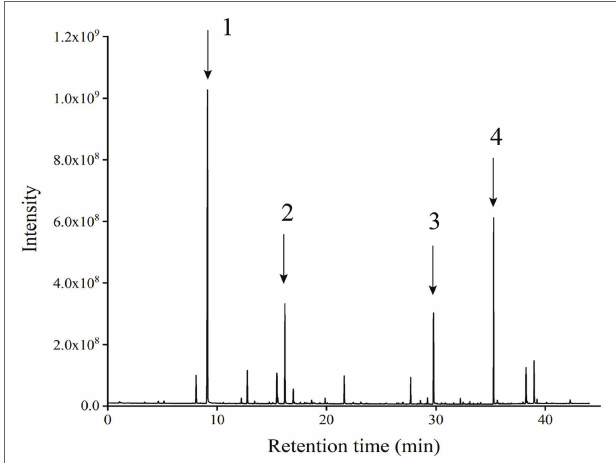
FIGURE 3 | Chromatographic patterns of flavoured components in the liquid fermentation of strain Y-1 (Numbers 1, 2, 3 and 4 represent ethyl hexanoate, ethyl caprylate, phenyl ethanol and ethyl palmitate, respectively).